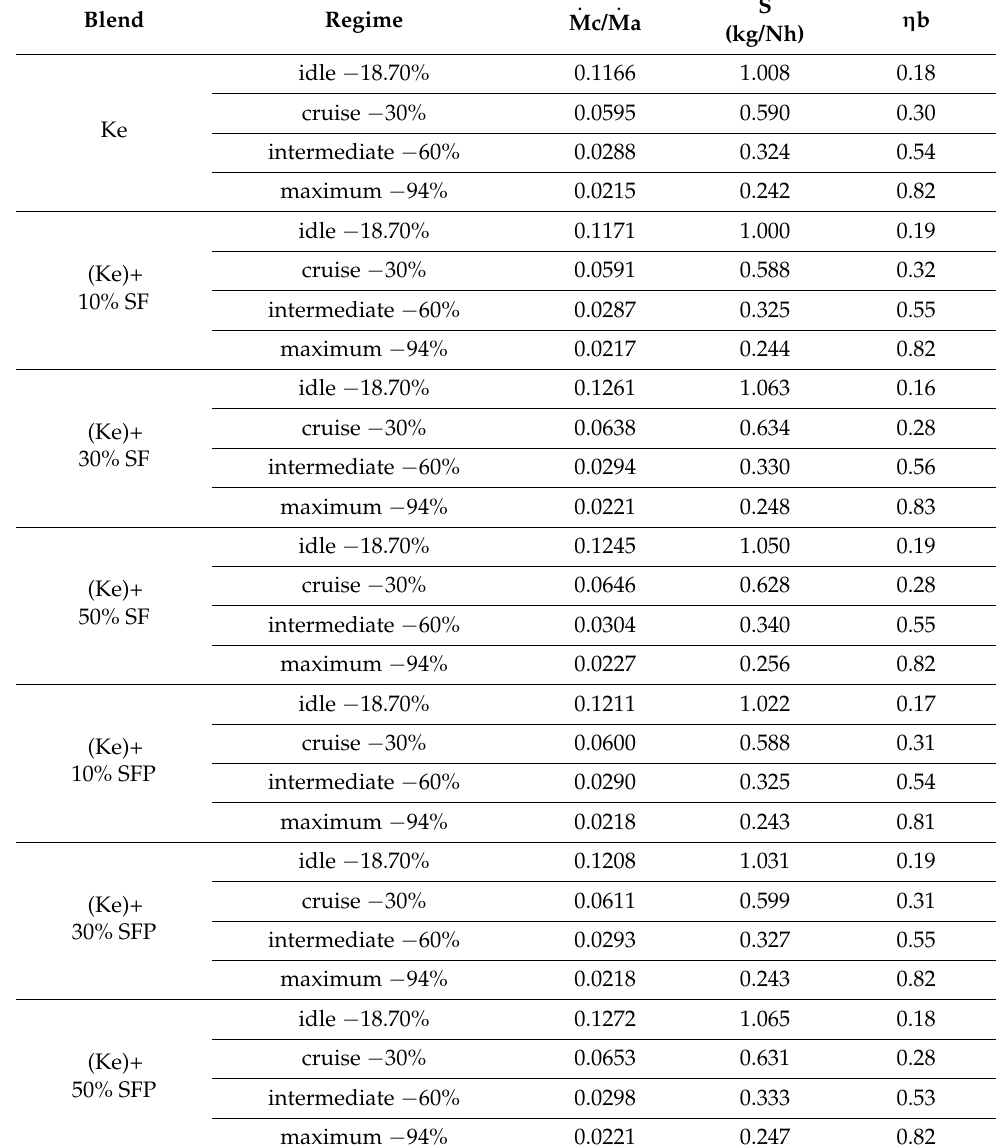
Table 3. Calculated performances obtained for all four regimes and for all tested blends.